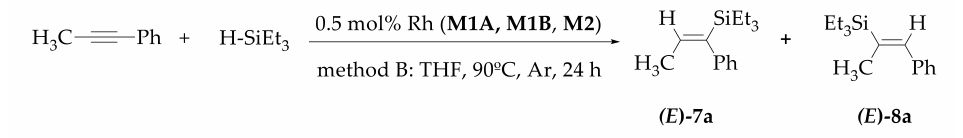
Table 6. Recycling of Rh NPs in the hydrosilylation of 1-phenyl-1-propyne.